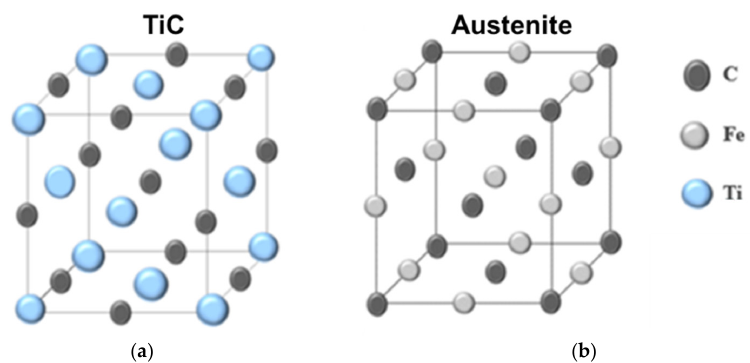
Figure 8. Schematic illustrations of ( a ) TiC and ( b ) austenite crystals.